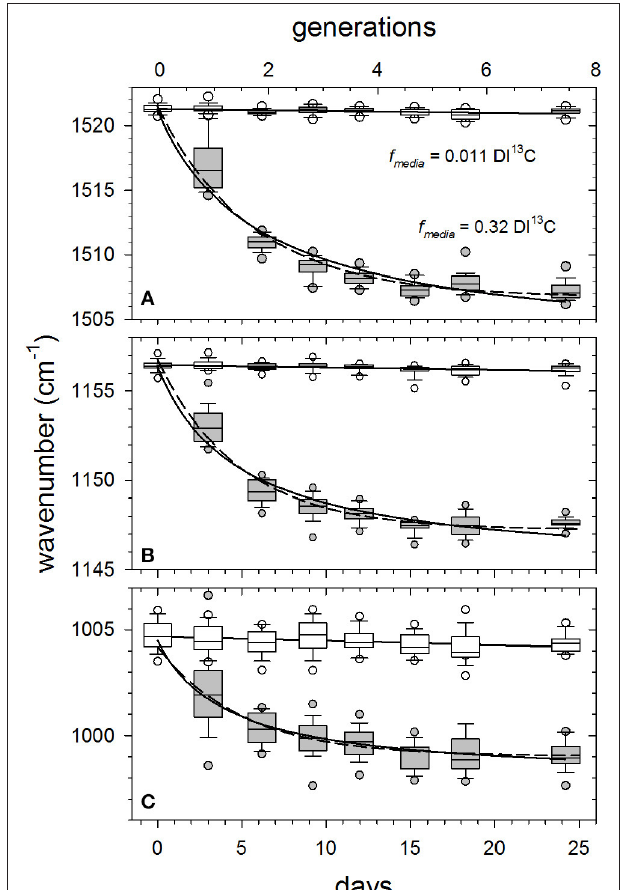
FIGURE 4 | Examples of growth-dependent shifts in mean wavenumbers h 1 ˜ ν i of the major carotenoid resonance Raman spectral peaks as Synechococcus sp. (RS9916) cells grown in 0.32 f media compared with 0.011 f media controls. Generations (n) were calculated from generation times (g) presented in Figure S1 and incubation times (n = t/g). Box and whisker plot details are as described in Figure 3 . Solid curves are hyperbolic fits to all observations ( N = 325 cells). Dashed lines are theoretical predictions for a population isotopically equilibrating with its media based on wavenumber response to f cell and generation time ( see SM 2 and SM 3 for derivation ). Solid horizontal lines are least square means of all observations in control samples. Peak assignments are (A) ν (C = C), (B) ν (C-C), and (C) δ (C =